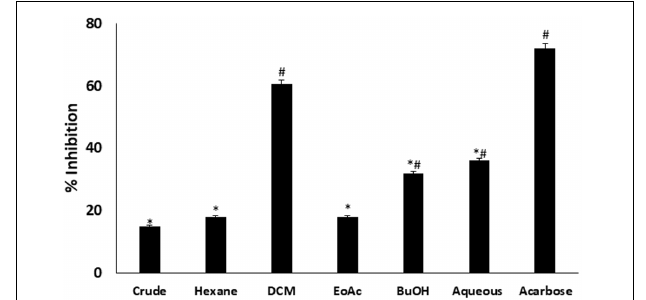
FIGURE 1 | Inhibitory effect of C. volubile methanolic extract and fractions on α -glucosidase activity. Data = mean ± SD ; n = 3. ∗ Statistically significant ( p < 0.05) compared to Acarbose; # statistically significant ( p < 0.05) compared to crude extract. Crude, crude extract; Hexane, hexane fraction; DCM, dichloromethane fraction; EoAC, ethyl acetate fraction; BuOH, butanol fraction; Aqueous, aqueous fraction.